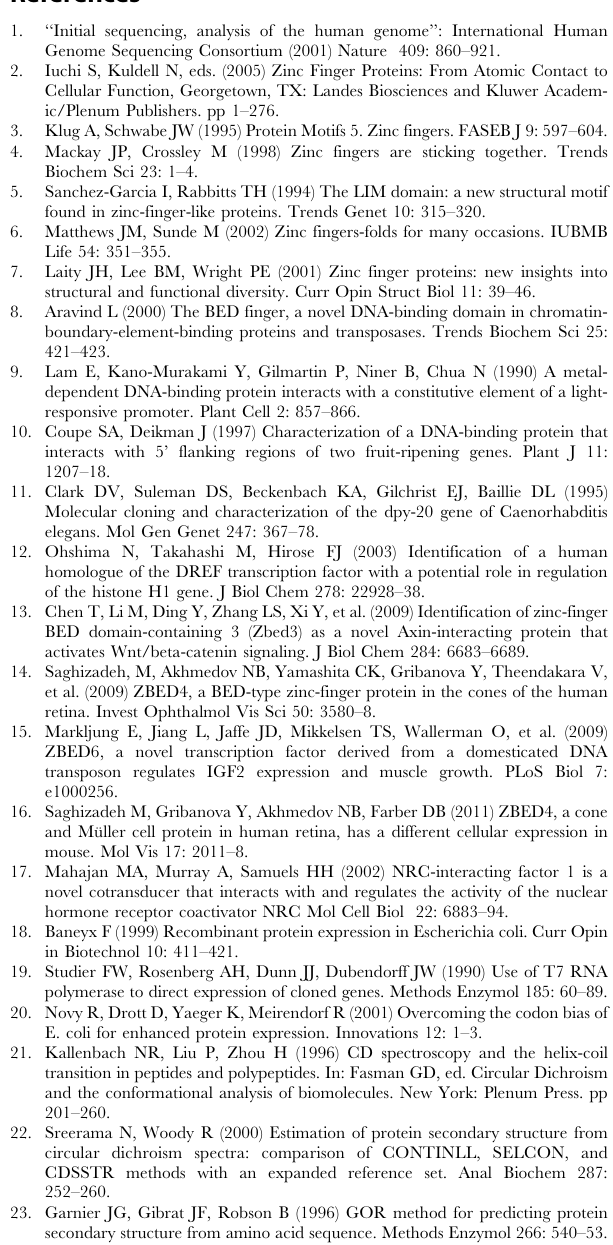
Table S1 Bacterial strain, eukaryotic cell lines and plasmids used in these studies. Table S2 Secondary structure content for Zbed4 at pH 7.3 determined from its CD spectrum. Table S3 List of primers used throughout these